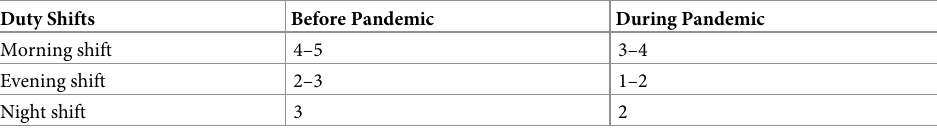
Table 1. Number of midwives in the maternity ward before and during pandemic. Duty Shifts Before Pandemic During Pandemic Morning shift 4–5 3–4 Evening shift 2–3 1–2 Night shift